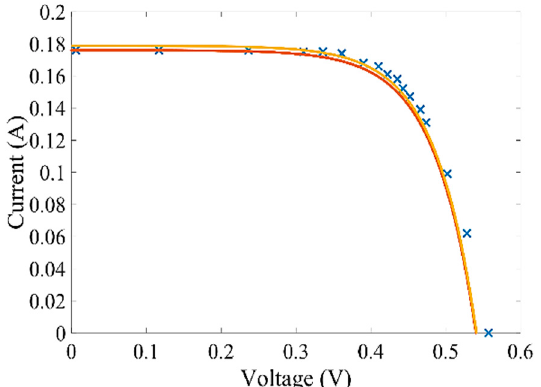
Figure 14. Experimental data acquired ( x ), characteristic curve that approaches the experimental data ( --- ), and simulated characteristic curve ( --- ), for the OG 550 filter.